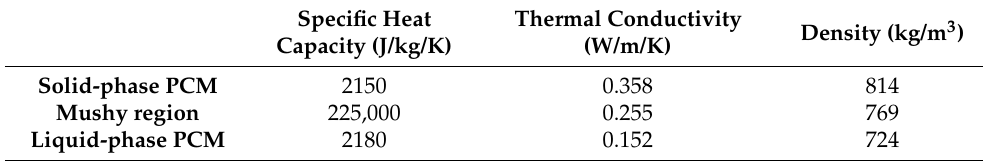
Table 3. Physical property parameters of PCMs, Reprint with permission